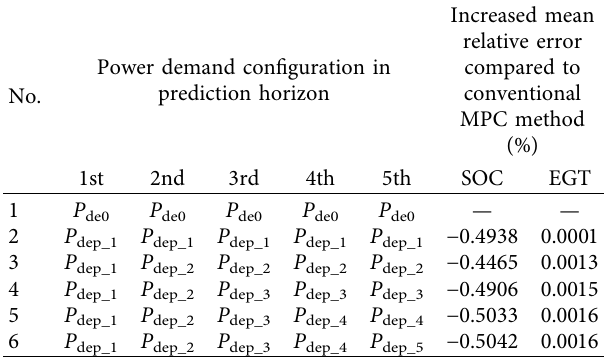
Table 5: Simulation results of different configuration of predictive power demands for the proposed predictor which adopts velocity and pedal position as inputs.